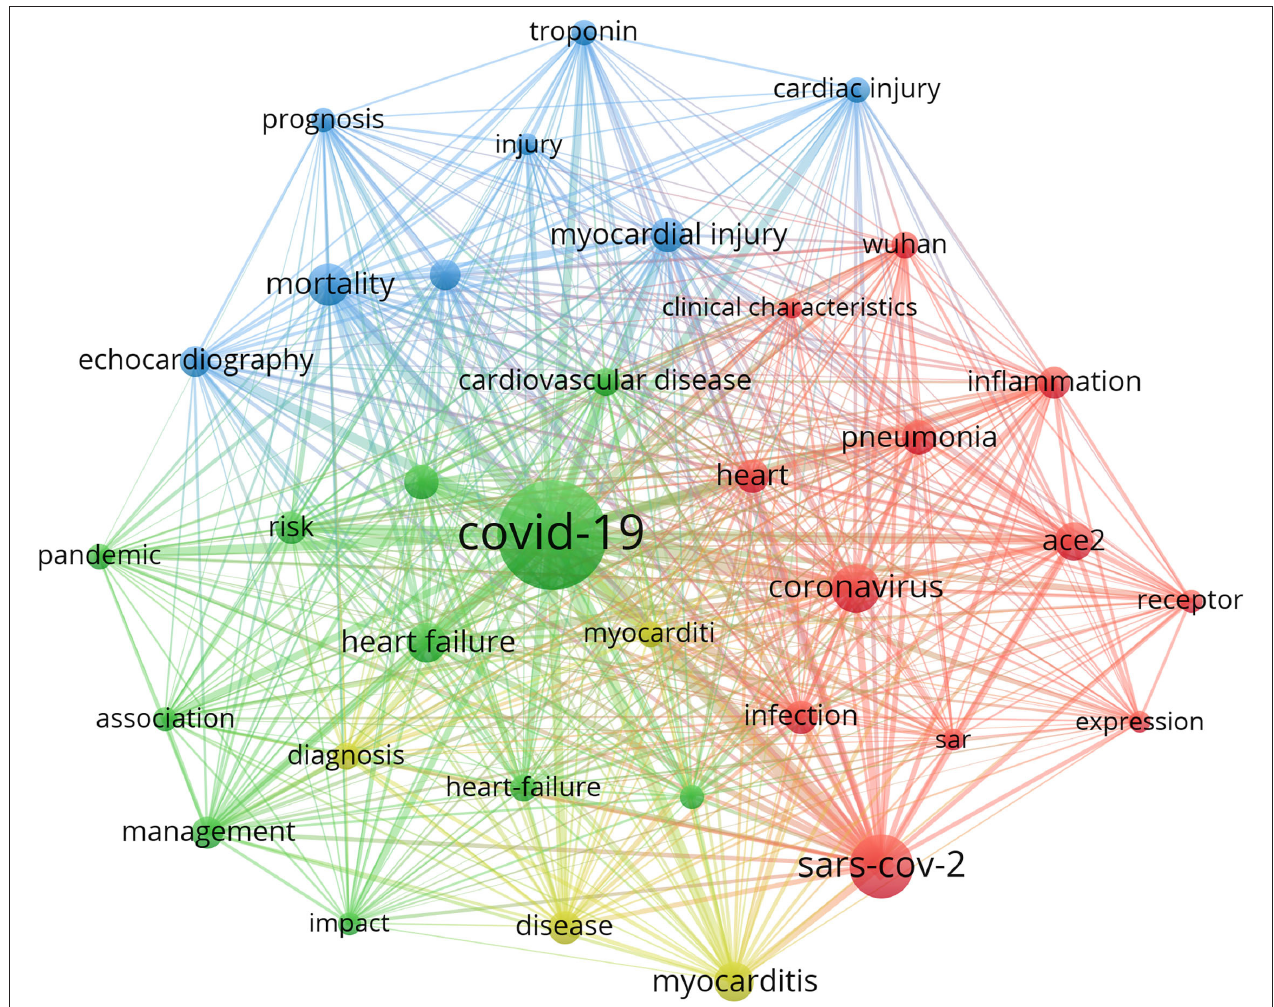
FIGURE 7 | The network mapping on keywords of cardiac involvement caused by COVID-19. The size of each circle represented the weight of a keyword. The distance between the two circles indicated the relatedness between the two circles. The stronger the relatedness, the shorter the distance. The color of the circles represented the respective cluster class. This figure displayed three clusters of red, blue, and green, indicating three research directions. Red clusters were composed of SARS-CoV2, coronavirus, ace2, pneumonia, inflammation, Wuhan, and heart. The keywords of the green cluster were COVID-19, management, heart failure, pandemic, and cardiovascular disease. The keywords of the blue cluster were myocardial injury, mortality, echocardiography, cardiac injury, and